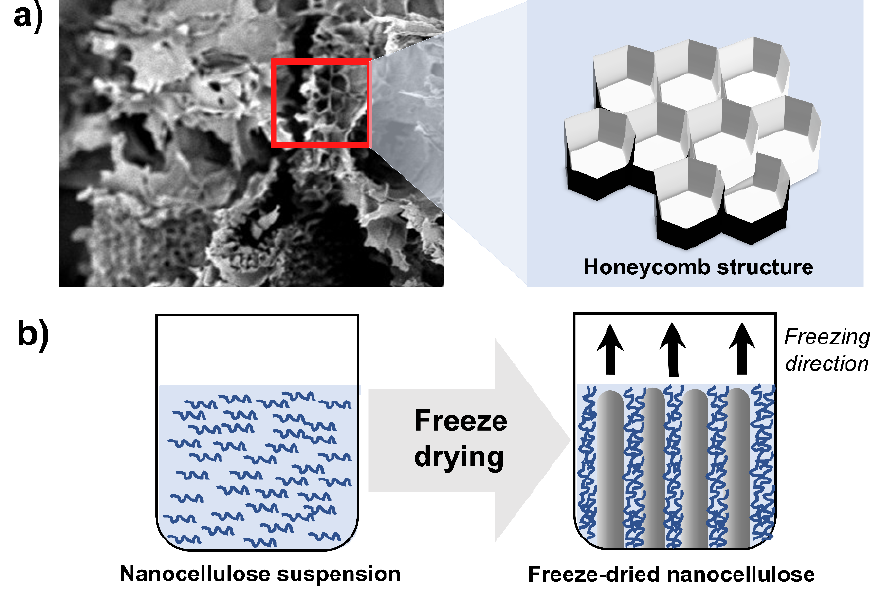
Figure 11. ( a ) Honeycomb structure produced by freeze drying of nanocellulose suspension and ( b ) mechanism of nanocellulose aggregation and ice ‐ crystals growth along the freezing direction. ( b ) mechanism of nanocellulose aggregation and ice-crystals growth along the freezing